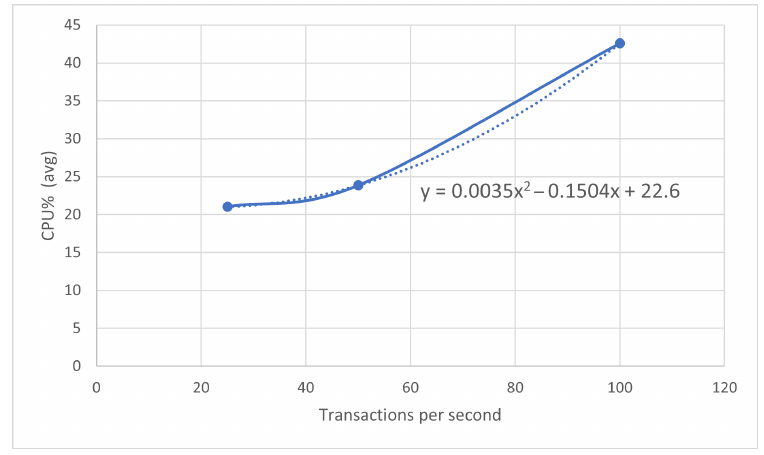
Figure 9. Percentage of CPU used for RPi3 and number of transactions per second.